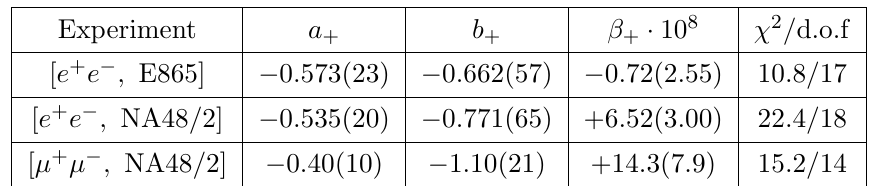
Table 2 . Results of the (cid:31) 2 (cid:12)ts with three parameters in each experiment. Only the statistical errors are